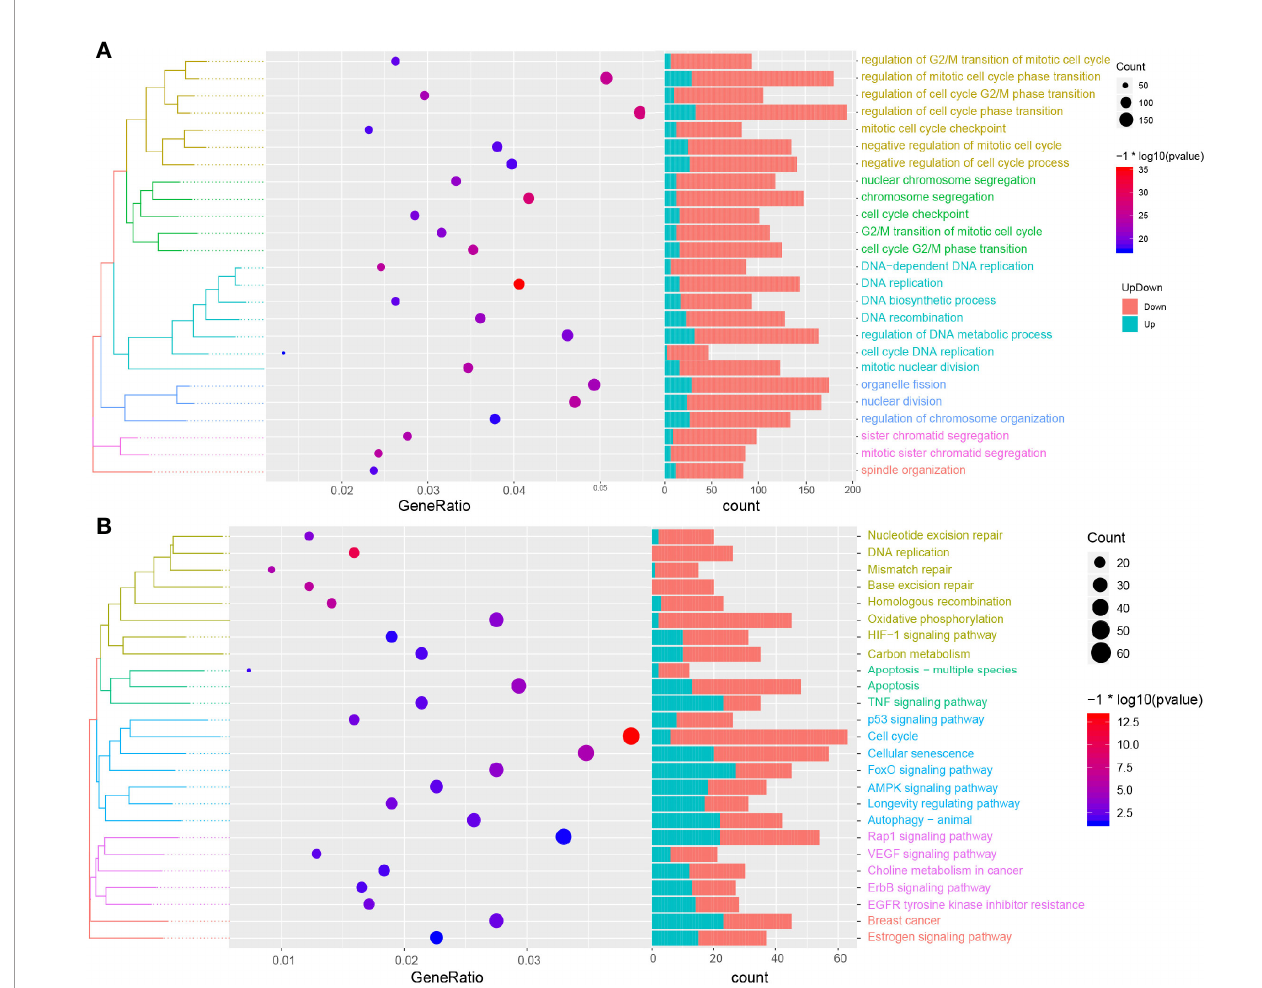
FIGURE 4 | Functional enrichment analysis and GSEA analysis. (A) Biological processes involved in resveratrol affected genes. (B) KEGG pathways involved in resveratrol affected